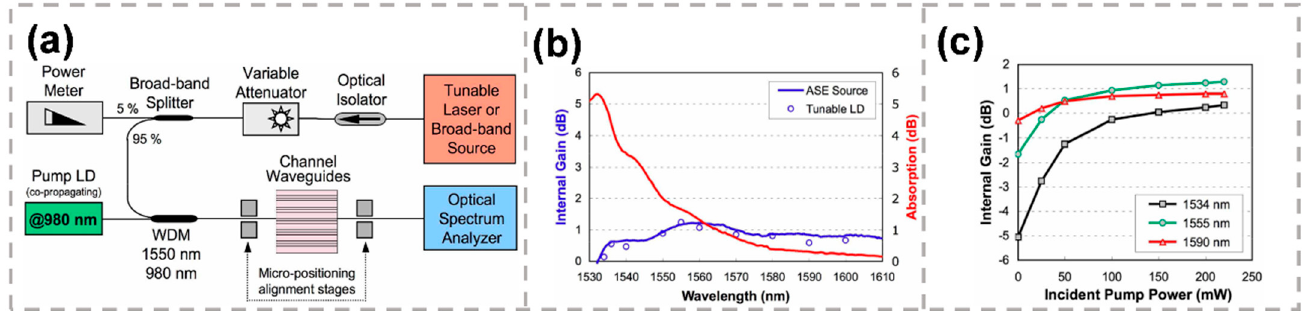
Figure 5. ( a ) Experimental setup for waveguide amplifier characterization. ( b ) Measured absorption spectrum (red) of the 25 mm-long active waveguide and internal gain (blue solid line and circles) at 200 mW incident pump power. ( c ) Internal gain at 1555 nm (circles), 1534 nm (squares) and 1590 nm (triangles) as a function of incident pump power [78]. Reproduced from [78] with permission of the Optica Publishing Group, 2022.